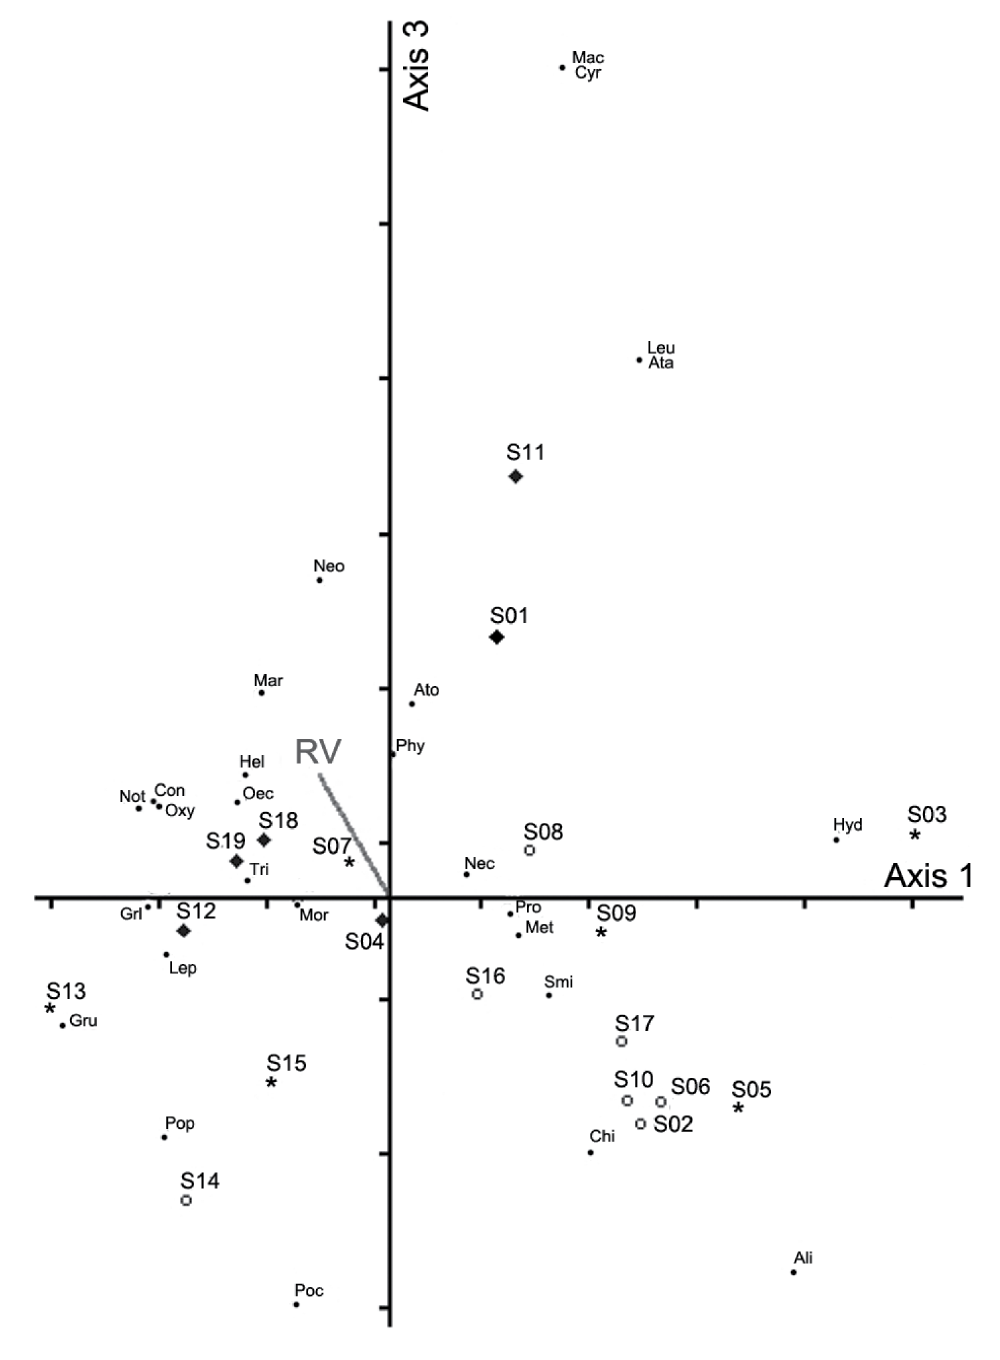
Figure 4. Canonical Correspondence Analysis (CCA) performed to 19 sites studied and environmental parameters at Serra da Bocaina Mountain. Axis 1 and 3. ♦ reference streams, * intermediate streams, ○ poor streams, RV- riparian